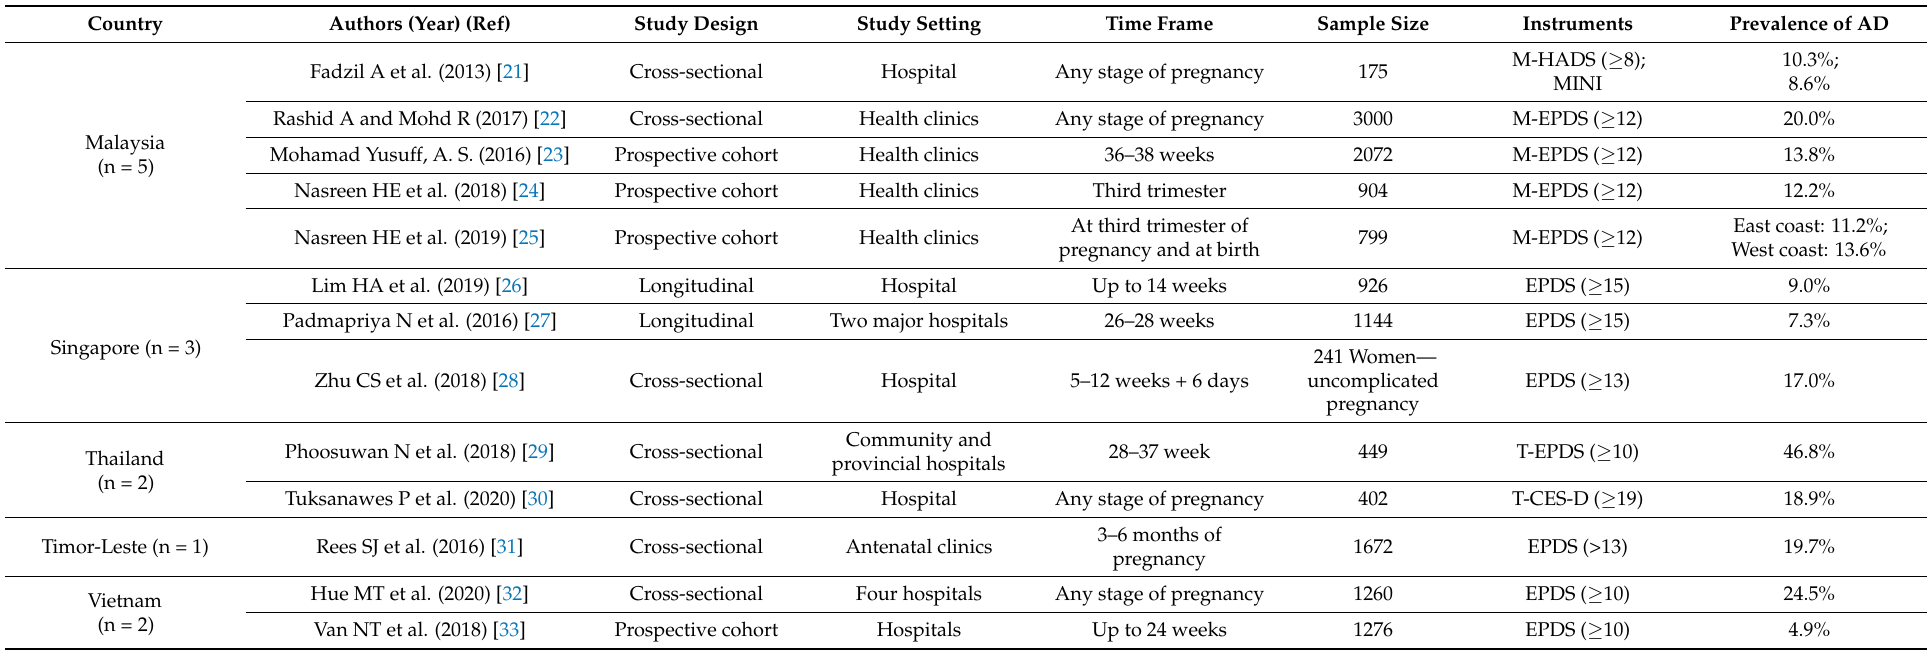
Table 3. Prevalence of antenatal and postnatal depression and their